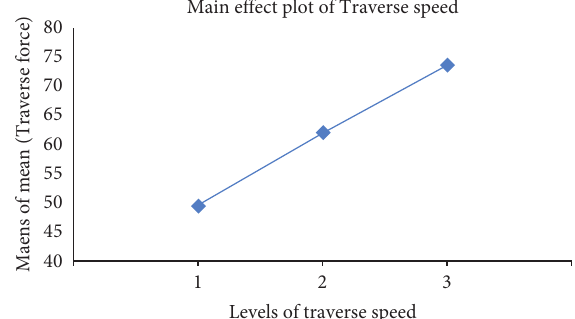
Figure 8: Main effect plot of traverse speed for means (traverse force).